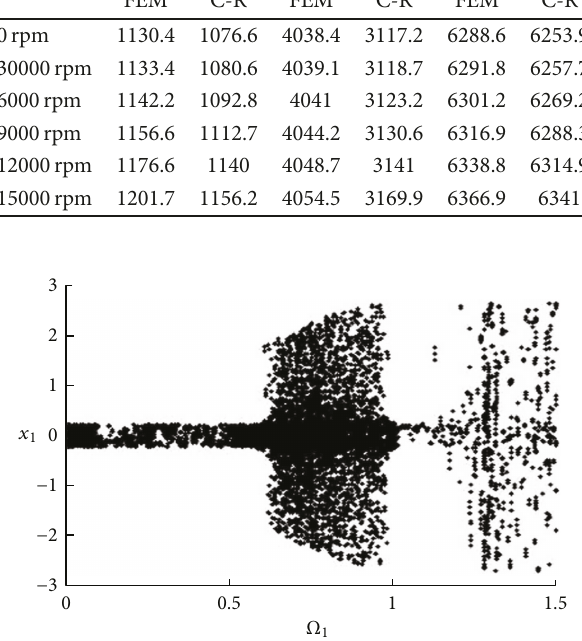
Figure 3: Bifurcation diagram on the plane x perturbation rotating speed Ω The initial condition is x = 1 2 x 40